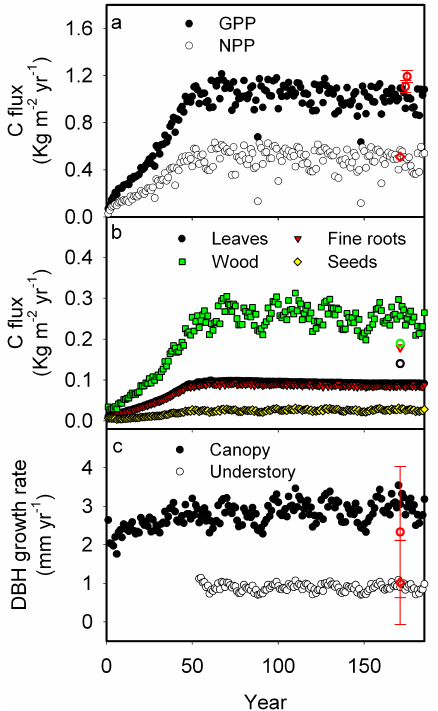
Figure 2. GPP, NPP, allocation, and DBH growth rate. Panel (a) shows GPP (closed circles) and NPP (open circles) simulated by LM3-PPA for one species (sugar maple) in the 1 ◦ × 1 ◦ grid cell containing the Willow Creek AmeriFlux site in Wisconsin, USA. The red open circles with error bars are GPP estimates from the Willow Creek eddy flux data (Desai et al., 2005). The red open dia- mond is NPP estimated from biometric data at Willow Creek (Cur- tis et al., 2002). Panel (b) shows the simulated allocation of NPP to leaves, fine roots, woody tissues (including stems, branches, and coarse roots), and seeds. The green open circle, red open triangle, and black open circle are NPP of wood, fine roots, and leaves, re- spectively, estimated from biometric data (Curtis et al., 2002). Panel (c) shows the DBH growth rates of canopy trees (closed circles) and understory trees (open circles) simulated for sugar maple. The red circle and diamond show growth rates of canopy and understory trees for sugar maple in the northern lake states, USA, estimated from FIA forest inventory data (Zhang et al., 2014). The error bars represent 1 standard deviation.